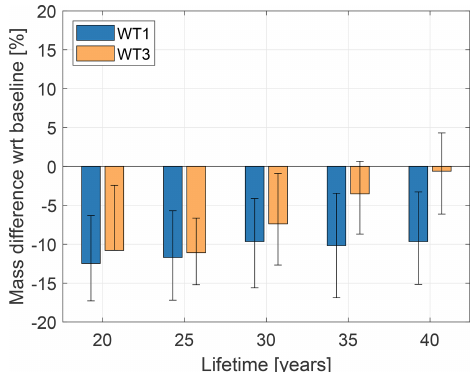
Figure 8. Effects of LAC on the redesign of towers of increas- ing lifetime with respect to 20-year non-LAC baselines. Solid bars: load-reduction model of Table 2; whiskers: range of the pessimistic and optimistic scenarios.